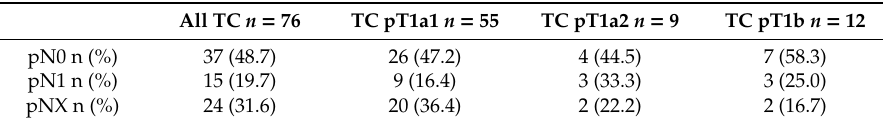
Table 1. Thyroid carcinomas (TC) and lymph node metastases stages.